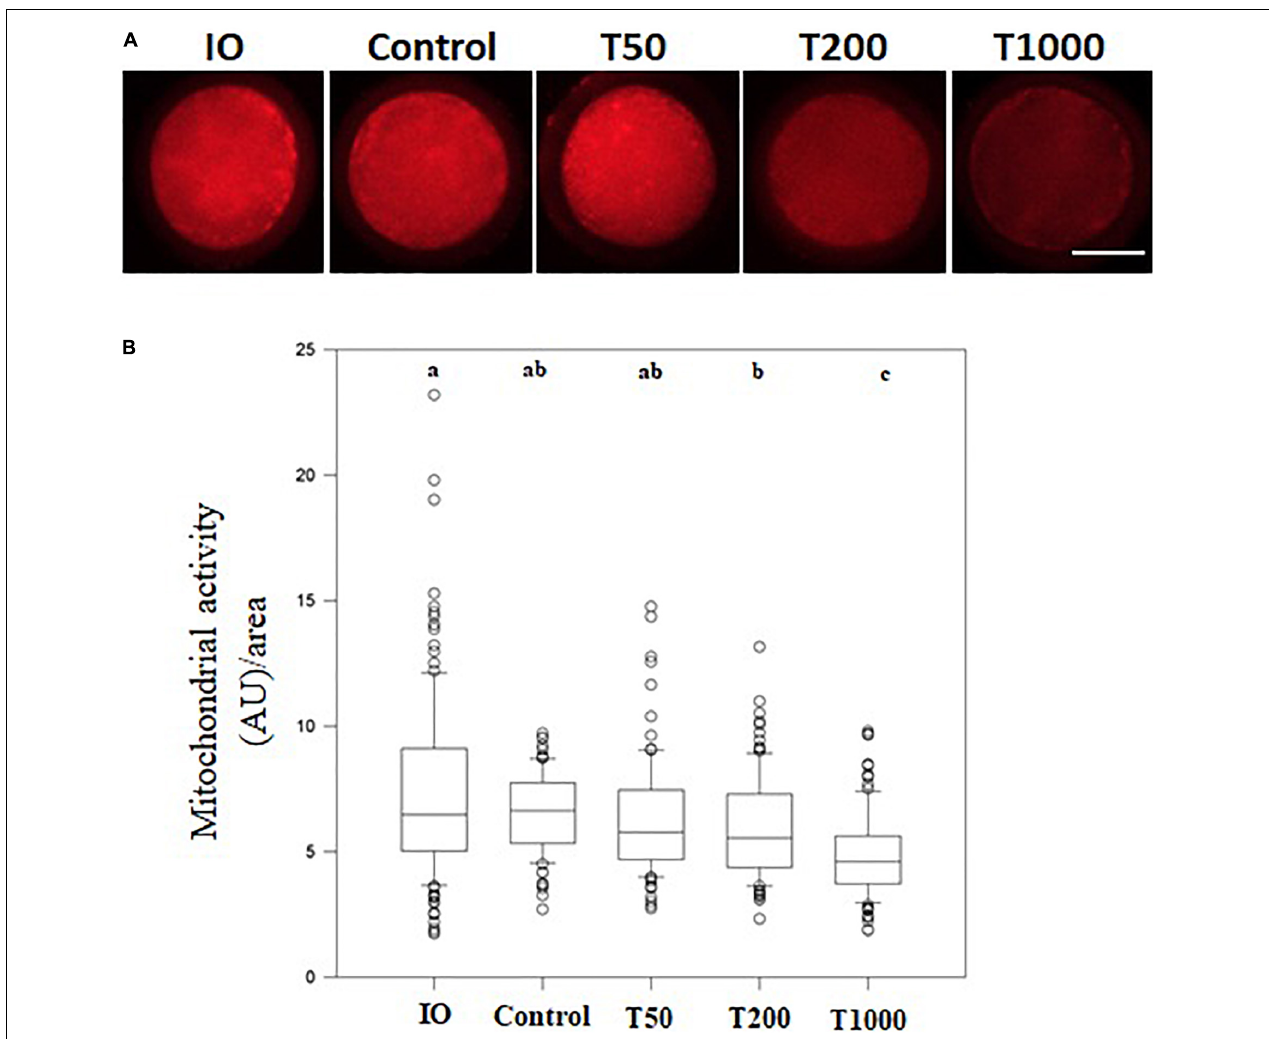
FIGURE 4 | Mitochondrial activity in oocytes matured in vitro in the presence of increasing TUDCA concentrations. (A) Representative photomicrographs of bovine oocytes stained with Mito Track Red CMX ROS for mitochondrial activity semi-quantitative quantification. Bar = 50 µ m. (B) Results are presented as the median and first and third interquartile interval of five replicates using 87–105 COCs/treatment. Different letters in each box represent significant differences ( P ≤ 0.06). IO, immature oocyte; Control, 0 µ M TUDCA; T50, 50 µ M TUDCA; T200, 200 µ M TUDCA; T1000, 1,000 µ M